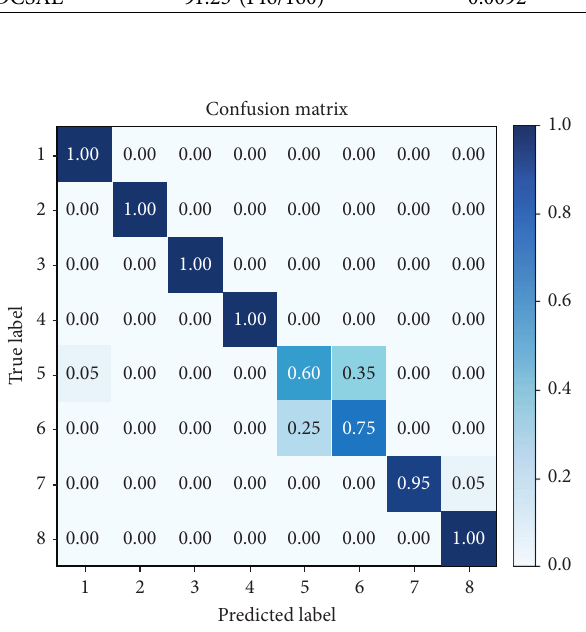
Figure 12: Confusion matrix of DCSAE for experiment